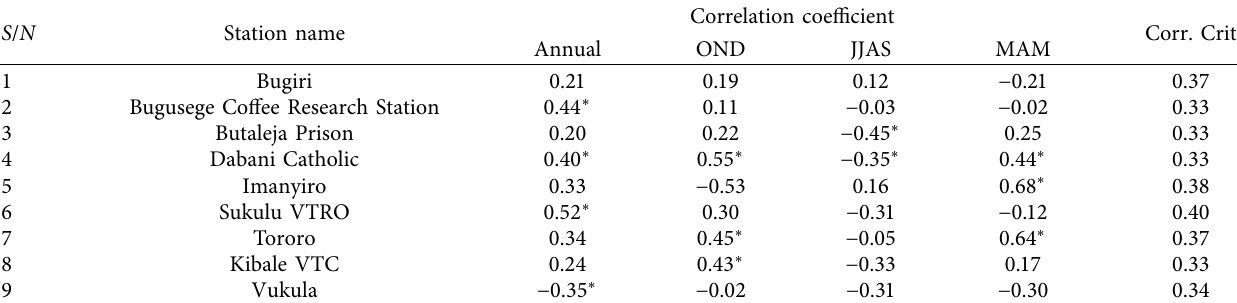
Figure 10: Spatial differences in the significance of evapotranspiration variability (a) and temporal variability (b–e) in MAM evapo- transpiration at different locations of the study area. Table 2: Correlation between PGF-gridded rainfall and observed rainfall at the selected stations for annual and seasonal (OND, JJAS, and MAM) time